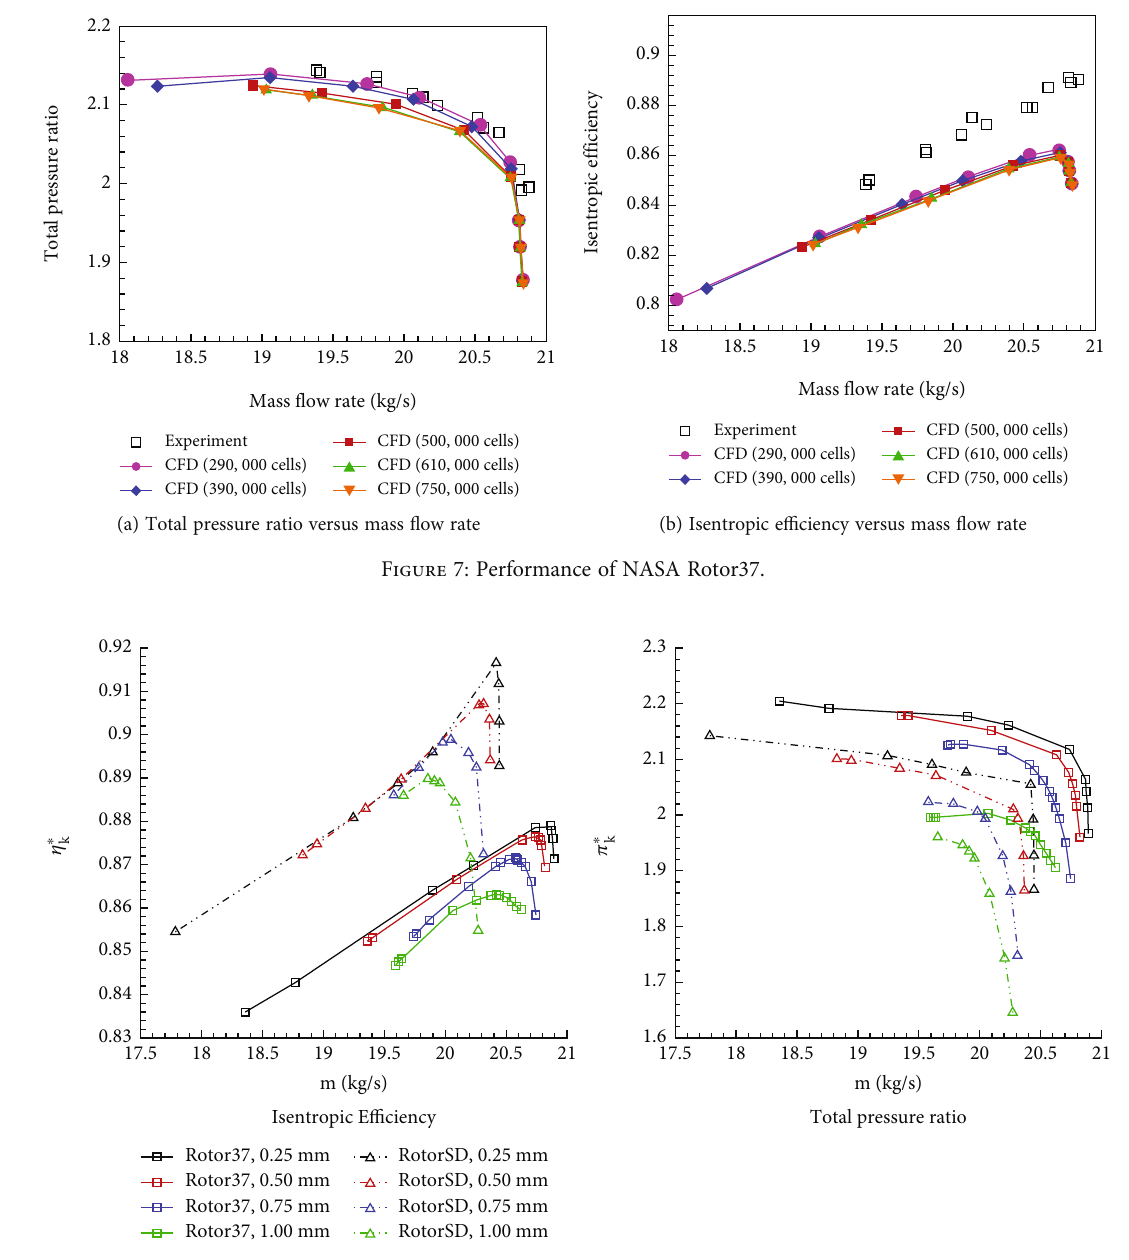
Figure 8: Comparison of the characteristics of the two rotors with di ff erent